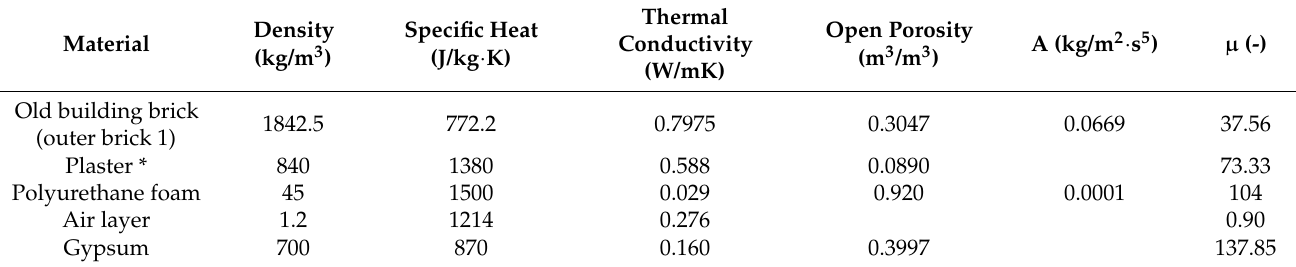
Table 1. Material properties of the historical brick (DELPHIN material